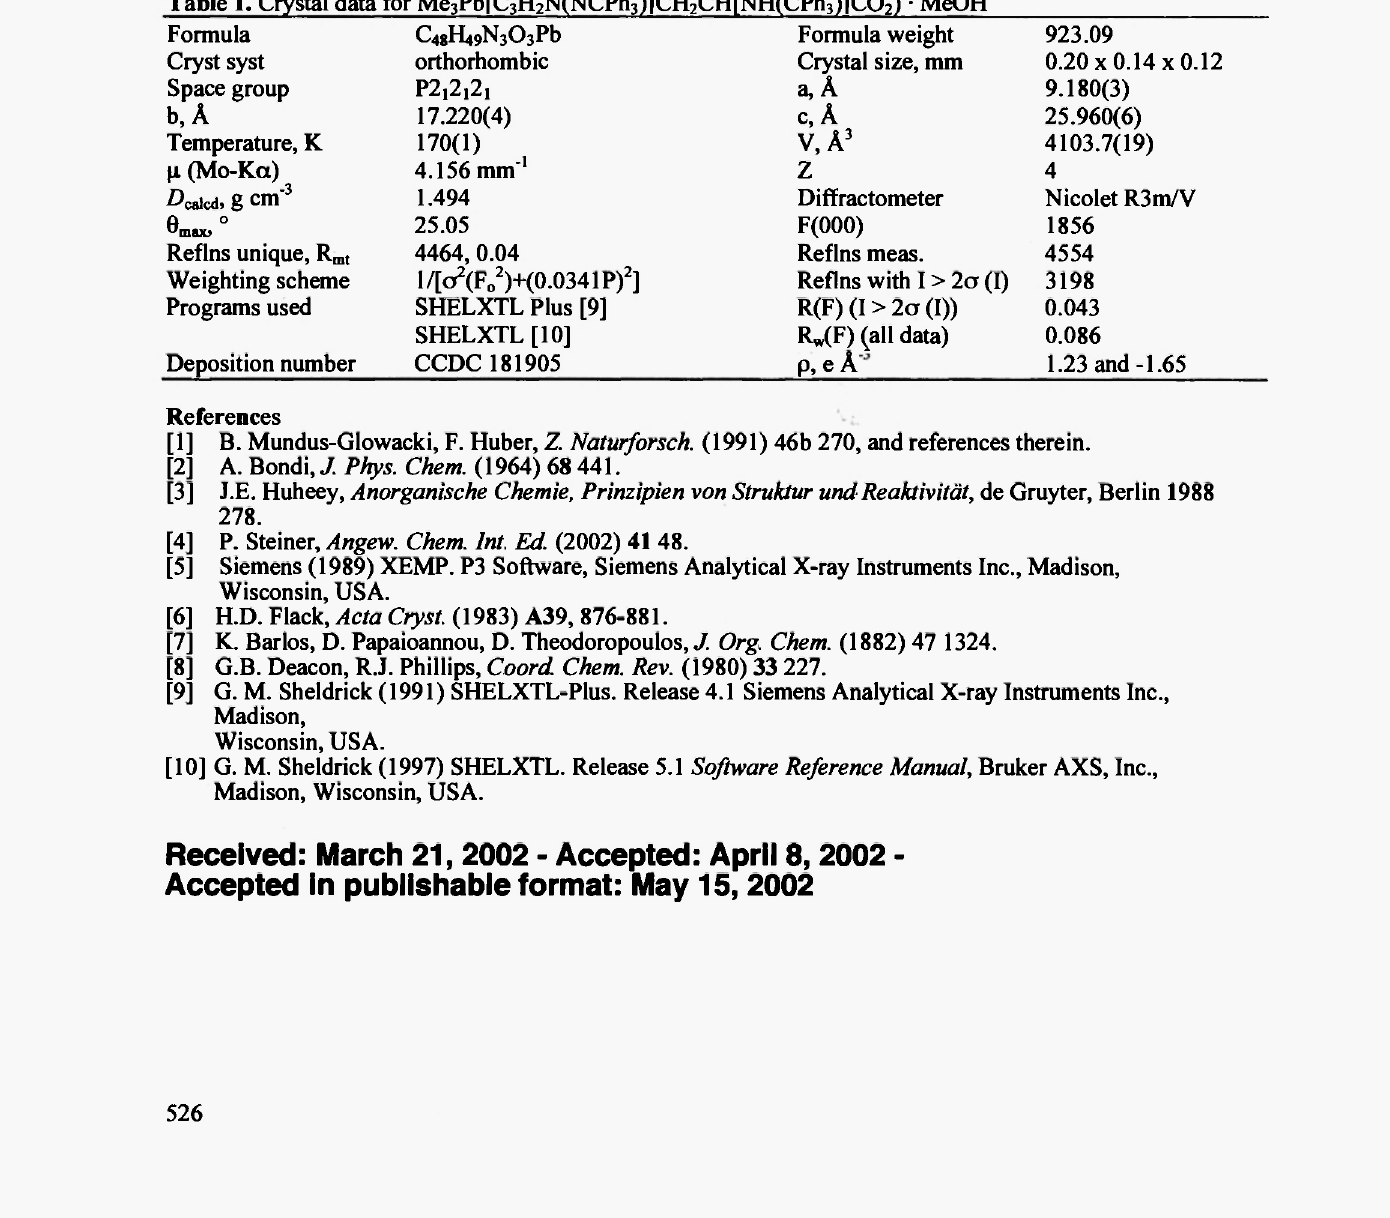
Table 1. Crystal data for Me3PbfC 3 H2N(NCPh 3 )1CH 2 CH[NH(CPh,)1C0 2 ) ·